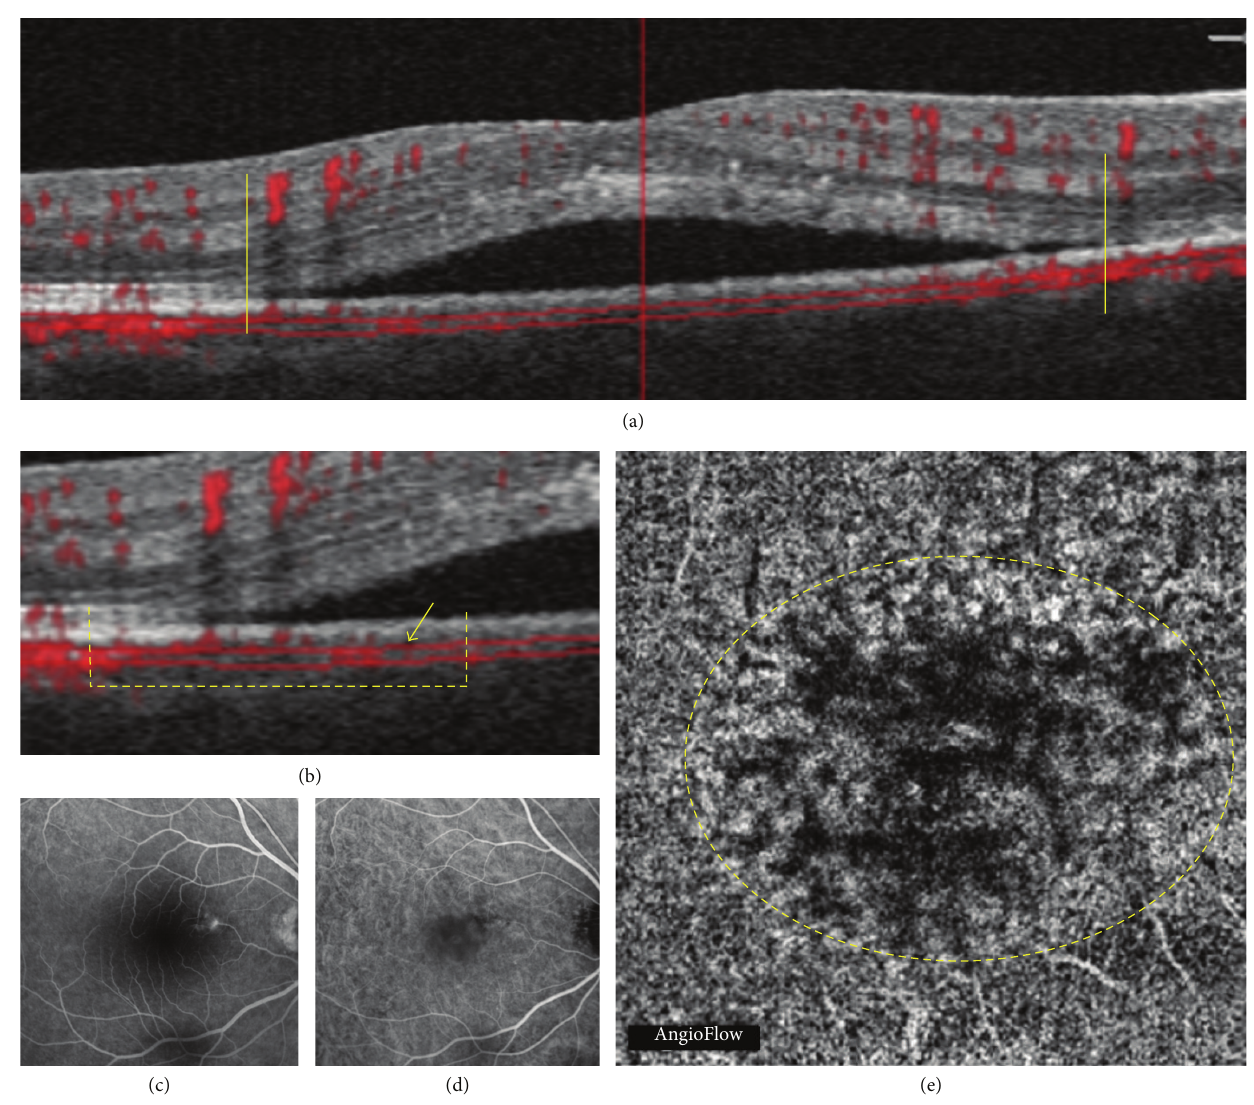
Figure 1: Acute central serous chorioretinopathy in a 48-year-old man. Correlation between optical coherence tomography (OCT), OCT angiography (OCTA), fluorescein angiography (FA), and indocyanine green angiography (ICGA). (a) OCT B-scan: the yellow vertical lines indicate the limits of the serous retinal detachment (SRD). (b) Detail of the OCT B-scan: the dashed yellow line shows the transition between the non-SRD and the SRD area; the yellow arrow indicates the area of flow reduction. (c) Late phase of FA: hyperfluorescent leaking point. (d) Early phase of ICGA: abnormal dilation of choroidal vessels. (e) OCTA at the choriocapillaris: the dashed yellow circle delineates an area of apparent blood flow reduction, called dark area in this